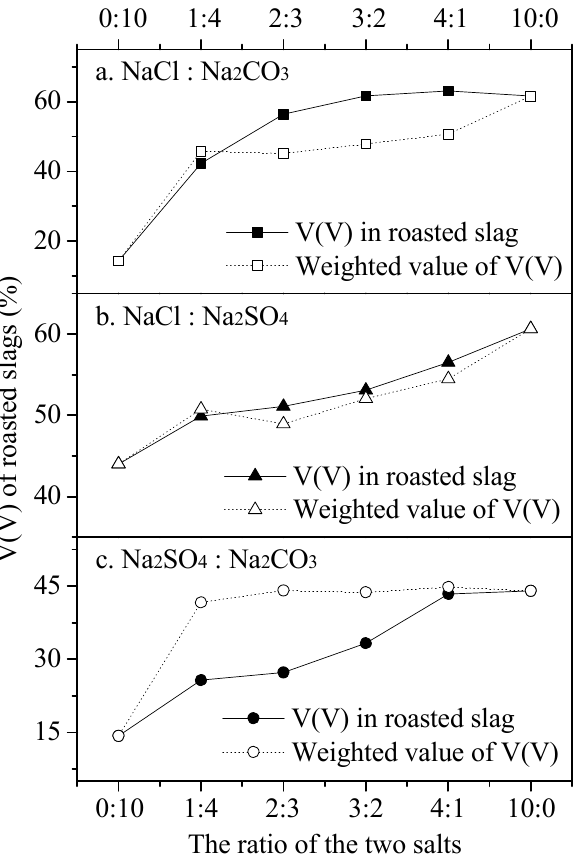
Figure 3. Influence of the ratio of two salts on V(V).